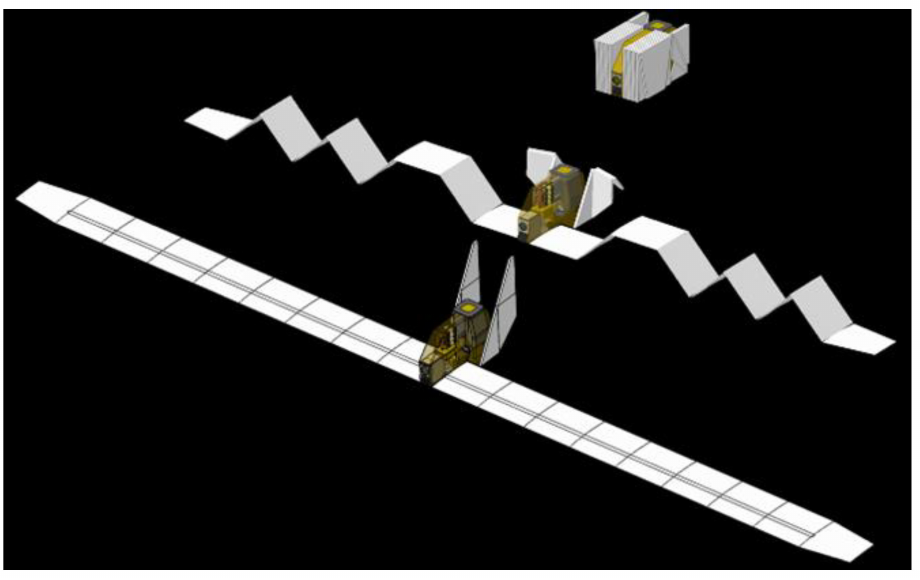
Figure 14. Inflatable wing design using an accordion fold